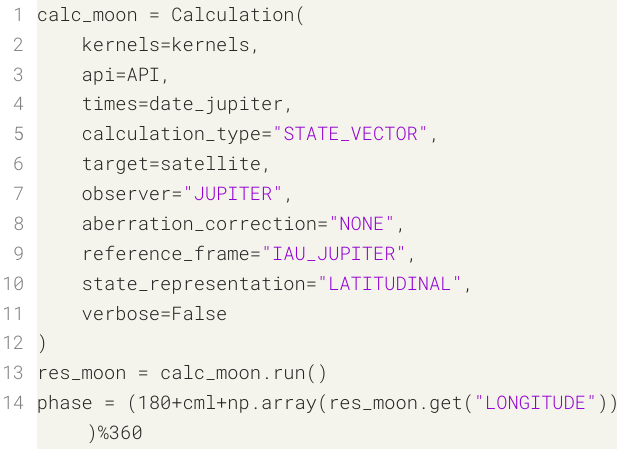
Observatoryselection :Alistofpredefinedobservatories.Atthetimeofwritingofthepaper,thelistofobservatoriesis:NDA(NançayDecameter Array, Nancay, France), UTR-2 (Kharkiv, Ukraine), Iitate (Japan), LWA (Long Wavelength Array, New Mexico, United States), I-LOFAR